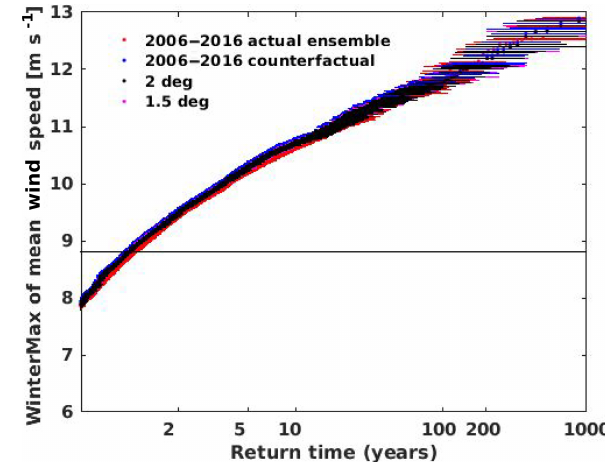
Figure 6. Return values as a function of return periods for the storm Friederike indicator, for the weather@home ensemble with 5%– 95% significance intervals, calculated from a nonparametric boot- strap, under the assumptions of actual, counterfactual, 1.5 ◦ C, and 2 ◦ C